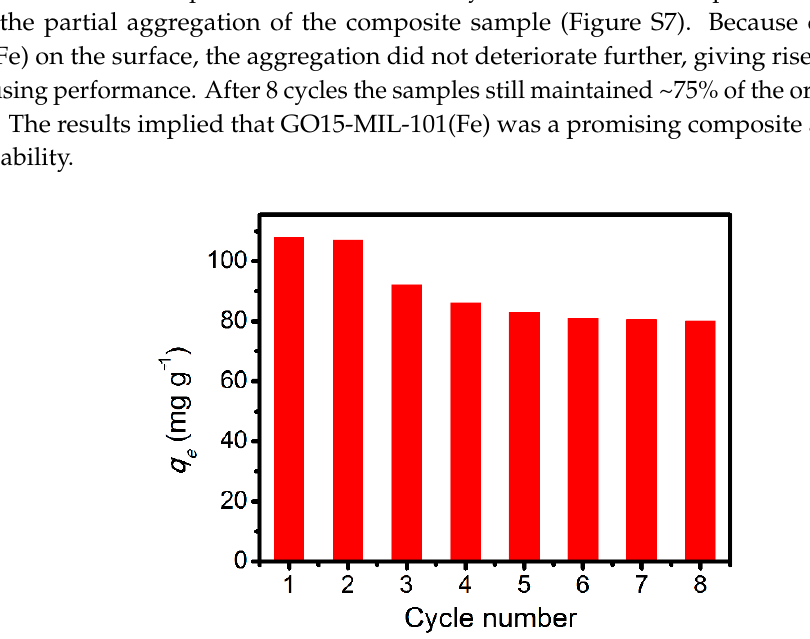
= 0.01 M). = 0.01 M). 3 3